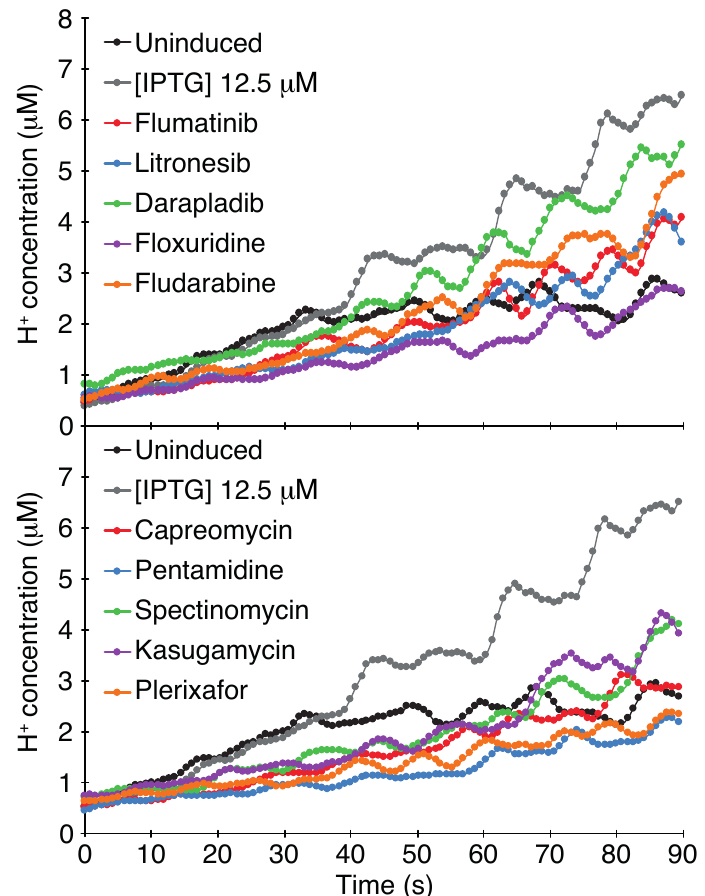
Figure 3. pH assay. Fluorescence of bacteria that harbor pHluorin, a pH sensitive GFP [59], was examined as a function of SARS-CoV-2 3a protein expression and different chemicals as indicated. The drugs were added at 50 µ M concentration. The H + concentration was determined as detailed in the Materials and Methods section. The analyses were performed in